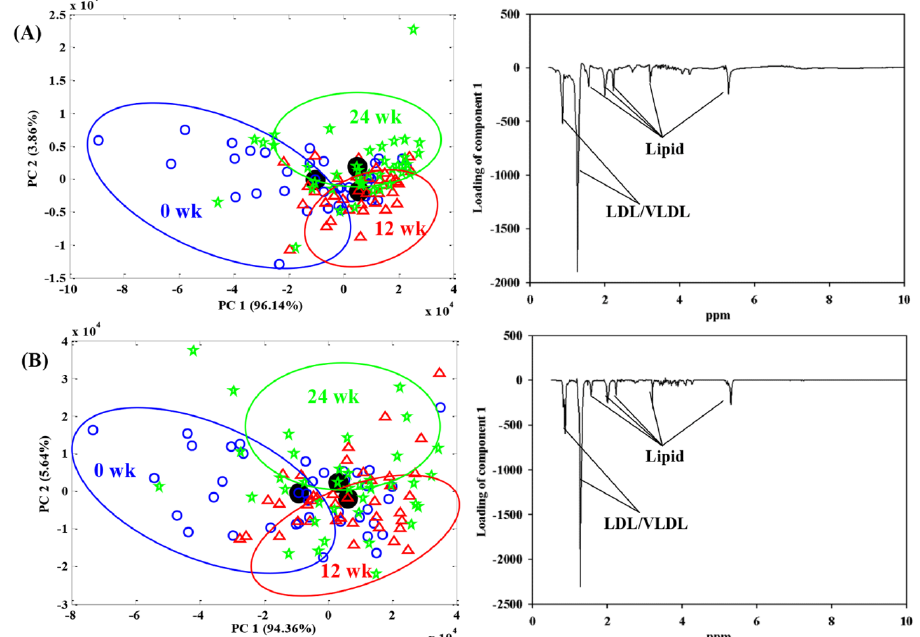
Figure 2. ASCA score and loading plots from NMR-based blood metabolomics in overweight/obese women who consumed the high and low dairy products at 0, 12 and 24 weeks: ( A ) “zgpr” data; ( B ) “cpmg” data. In the score plot, the scores of each sample are also included. Assignments: LDL/VLDL (0.85 and 1.27 ppm); lipid (1.57, 2.01, 2.23, 3.21 and 5.30 ppm).